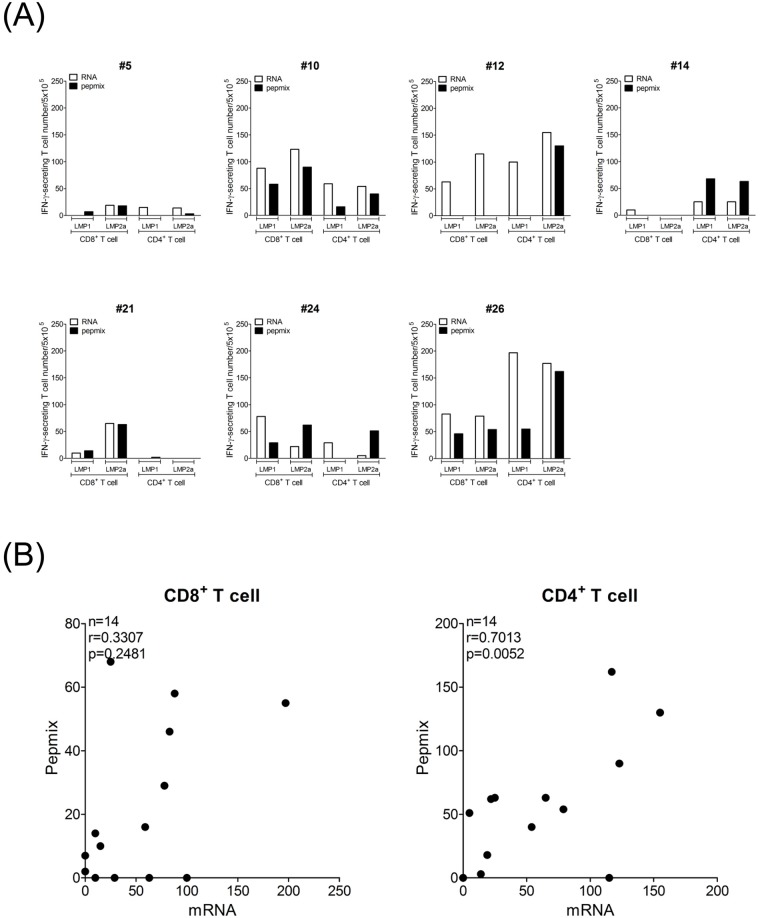
Comparison of IFN-γ ELISPOT responses specific to LMP1 and to LMP2a between DCs transfected with mRNA and pulsed with pepmix.(A) IFN-γ ELISPOT responses using mRNA and pepmix were measured in 7 donors. (B) Correlation of LMP1- and LMP2a-specific IFN-γ ELISPOT responses between mRNA and pepmix was analyzed in CD8+ and in CD4+ T cells of 7 donors.